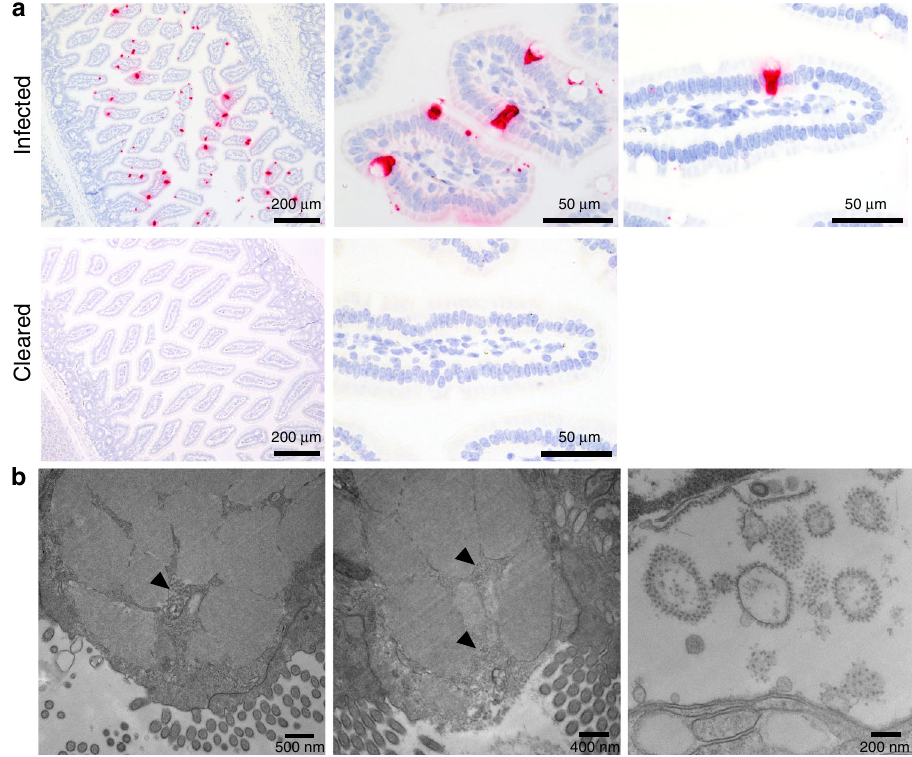
Fig. 1 Murine astrovirus replicates in goblet cells of the small intestine. a Small and large intestines were collected throughout infection of 8-week-old C57BL/6 mice and hybridized with murine astrovirus-speci fi c probes shown in red. The representative images show staining of cells with distinctive goblet cell morphology in the small intestine at 10 dpi ( n = 4 animals/group). b Duodenal goblet cells from infected animals ( n = 2) harvested at 8 and 10 dpi were analyzed by electron microscopy. Virus particles were visualized amongst mucin granules (black arrowheads) and replication bodies were evident in the perinuclear space (third panel). Data shown are from two independent